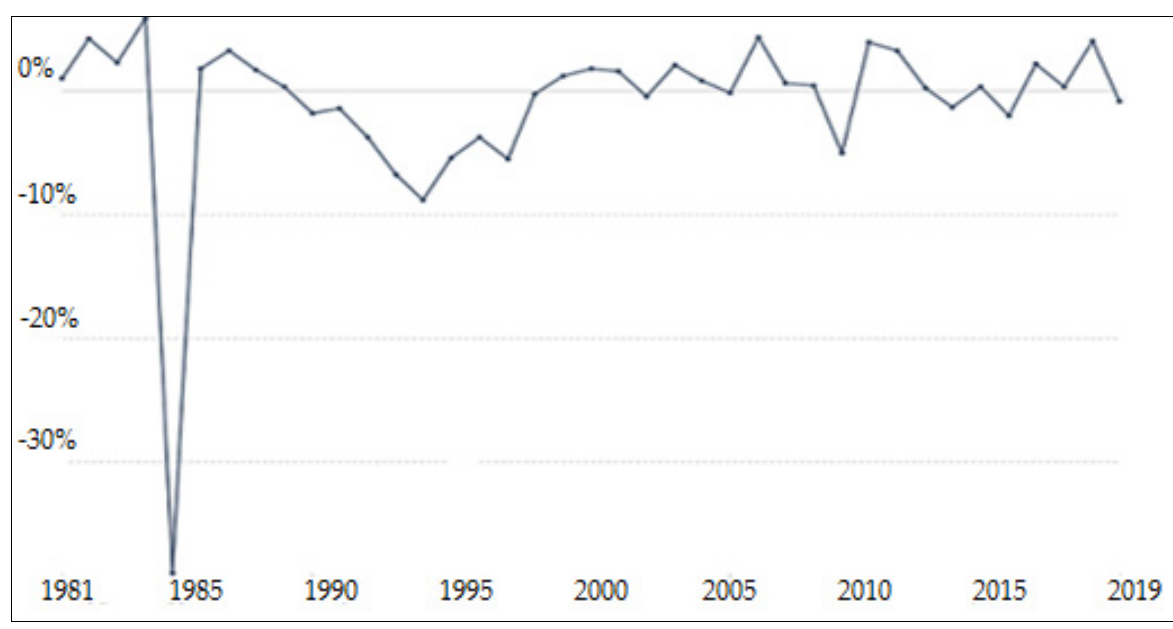
Figure 2. Annual change in Russia’s primary energy consumption. Source: [35].